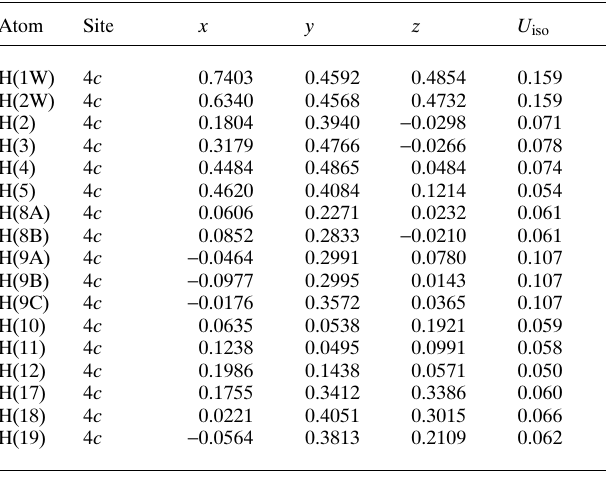
Table 2. Atomic coordinates and displacement parameters (in Å 2 )